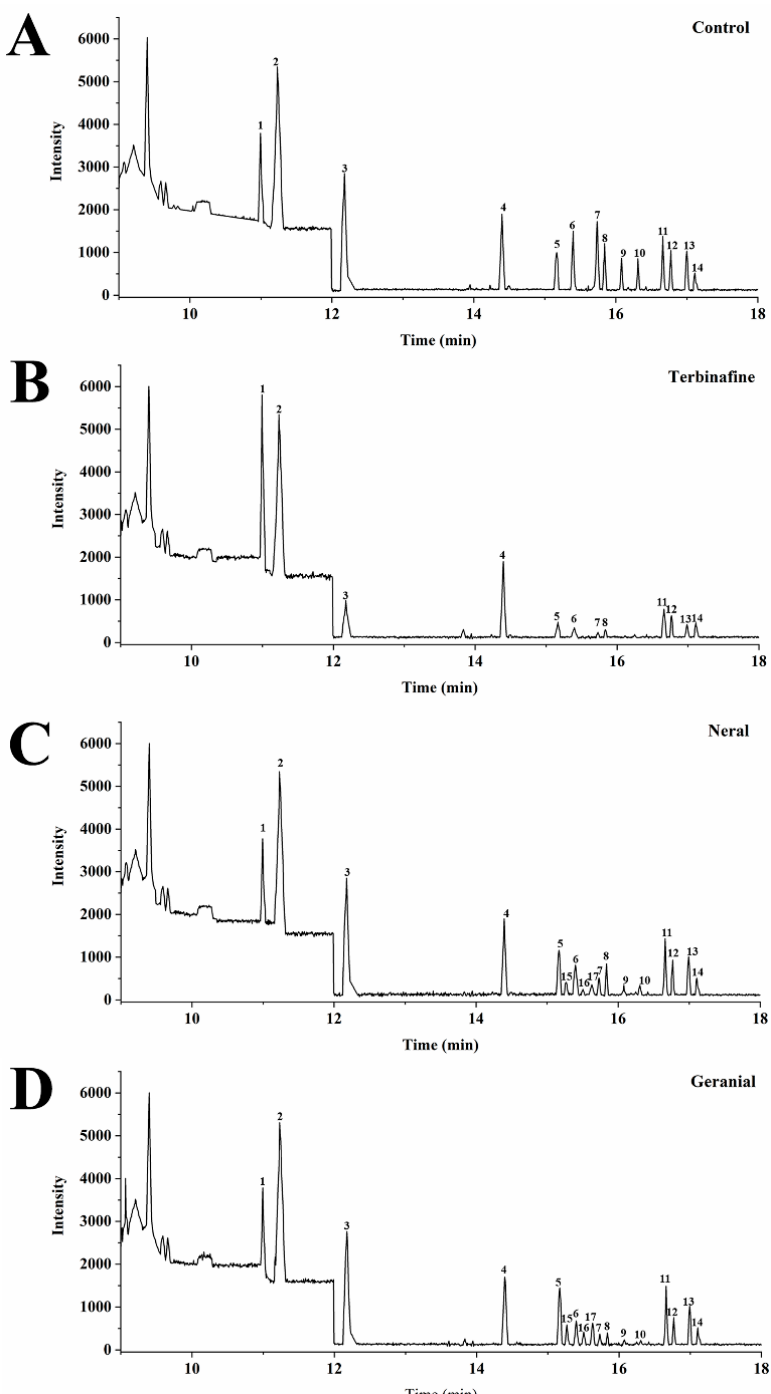
Figure 7. Gas chromatography diagrams of sterol patterns of Trichophyton rubrum in different treatment groups 5 days post-treatment. ( A ) drug-free control; ( B ) terbinafine (MIC); ( C ) neral (MIC); ( D ) geranial (MIC). (1) squalene; (2) cholestane (internal standard); (3) squalene epoxide; (4) cholesterol (internal standard); (5) zymosterol; (6) ergosterol; (7) dehydroergosterol; (8) fecosterol; (9) 5-Dehydroergosterol; (10) episterol; (11) lanosterol; (12) 4-Methylfecosterol; (13) 4,4-Dimethylcholesta-8,24-dien-3 β -ol(T-MAS); (14) 4,4-Dimethylcholesta-8,14,24-trien-3 β -ol (FF-MAS); (15) 7-Dehydrodesmosterol; (16) Cholesta-7,24-dien-3 β -ol; (17) Cholesta-5,7,22,24-tetraen-3 β -ol. MIC, minimum inhibitory